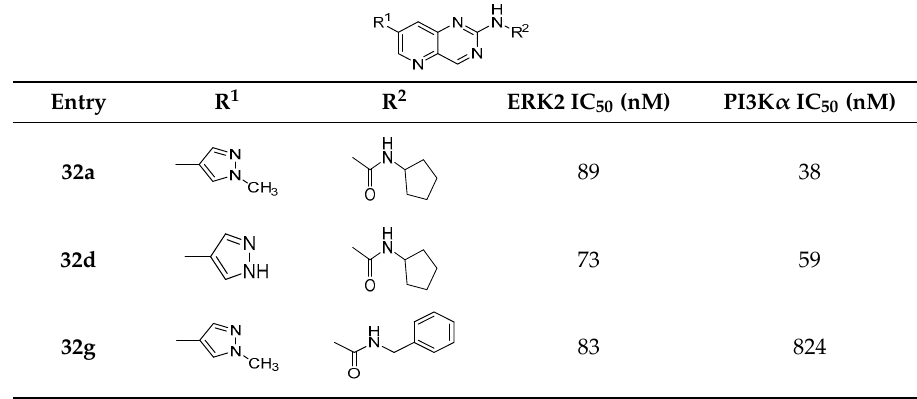
Table 4. In vitro ERK 2 and PI3K α IC 50 of compounds 32a , 32d and 32g.